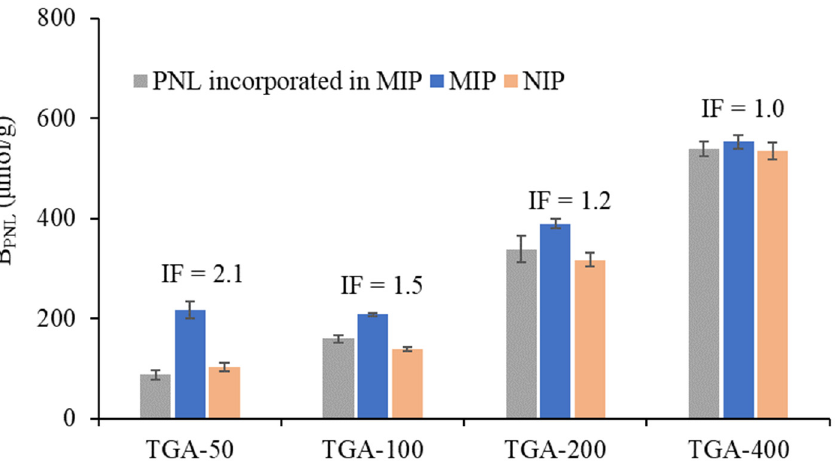
Figure 2. PNL binding of TGA-MIPs and their corresponding NIPs. A total of 2 mg of polymers were incubated for 2 h in 1.0 mL of 2 mM PNL rebinding solution, measured in triplicates for each of the four batches of MIPs synthesised. Post-rebinding solutions were analysed by q-HNMR. IF is the imprinting factor, which is the ratio of PNL bound in MIP to that in NIP. PNL incorporated within the MIP, also measured by q-HNMR (see Table 1), is included for comparison.